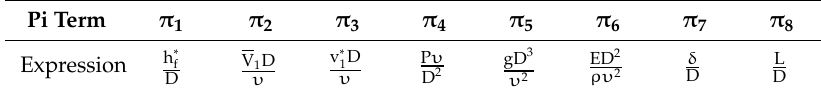
Table 3. Dimensionless π terms associated with the amplitude of the pressure head loss. Pi